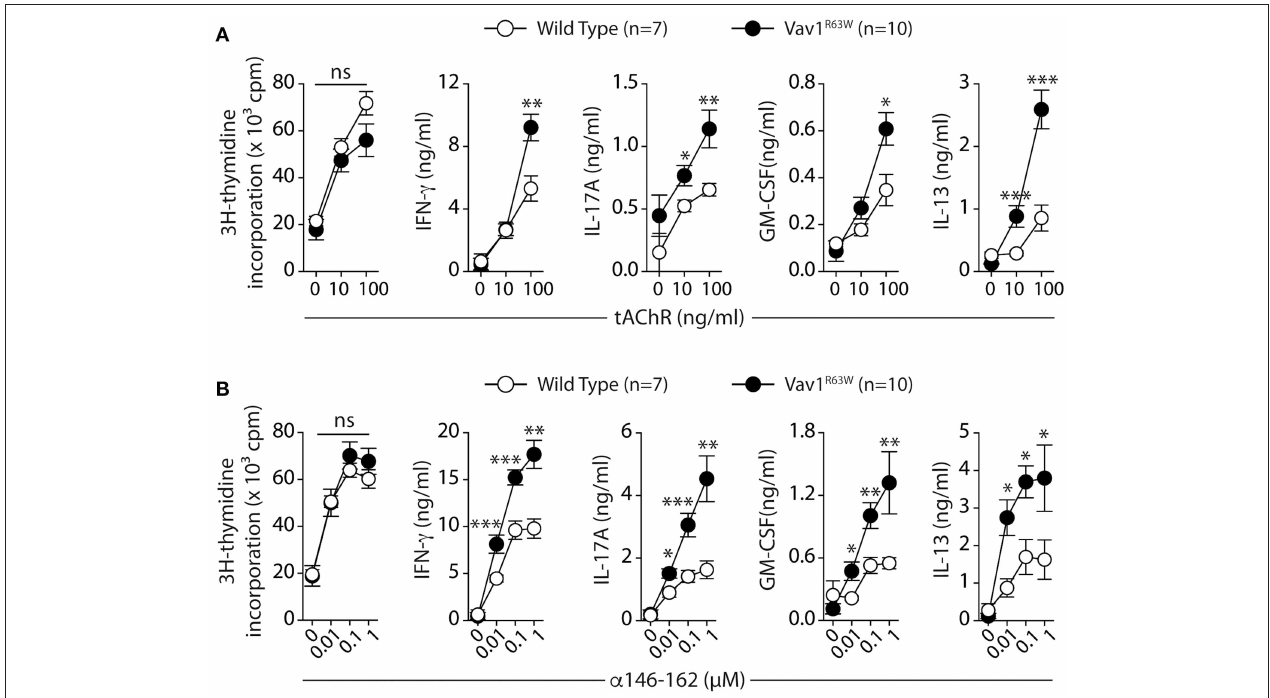
FIGURE 2 | Production of cytokines after tAChR immunization of WT and Vav1 R63W mice. WT or Vav1 R63W mice were immunized with 10 µ g of tAChR in CFA. Draining LNC were harvested 9 days later and stimulated for 48h with variable concentrations of tAChR (A) or with the α 146-162 immunodominant AChR peptide (B) . Cytokine secretion was quantified by ELISA and CBA kit in the supernatants. Data represent a pool of 2 independent experiments. Mann-Whitney test, ns, non-significant; * P < 0.05; ** P < 0.01; *** P < 0.005.